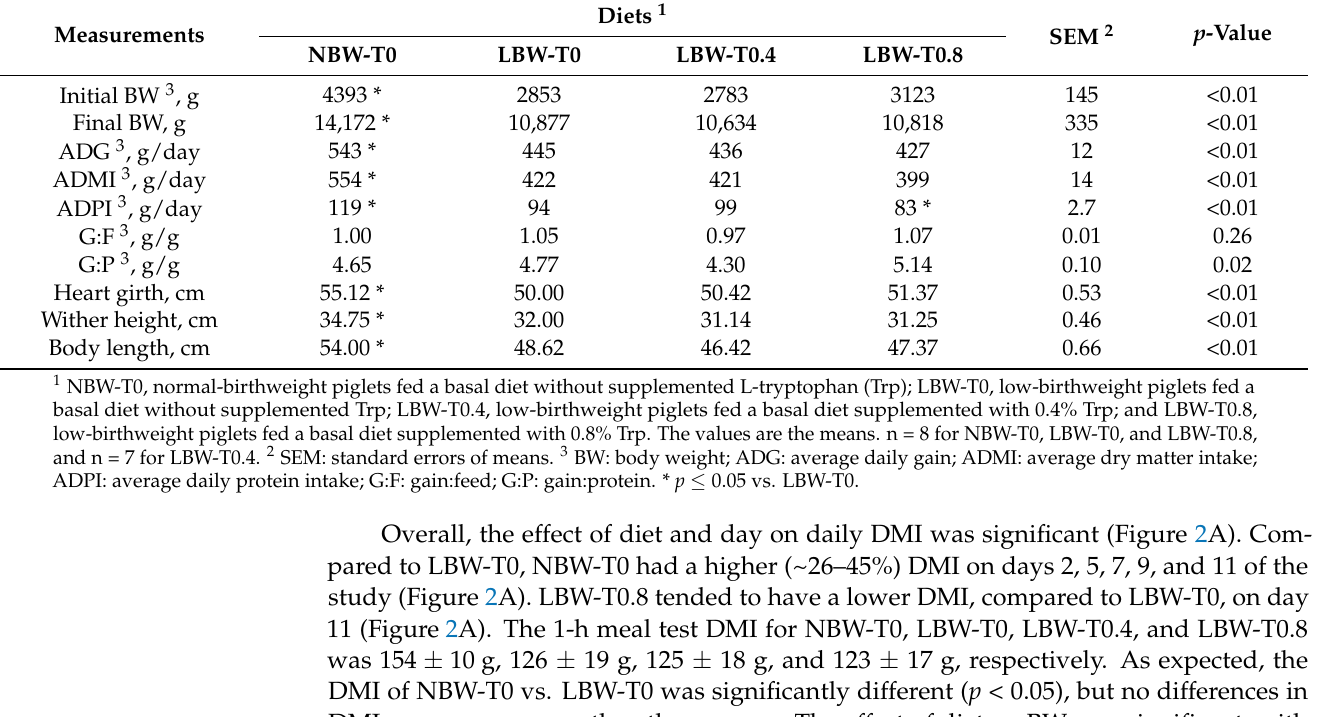
Table 1. Effect of dietary L-tryptophan supplementation on the growth and feed efficiency of low-birthweight neonatal pigs.